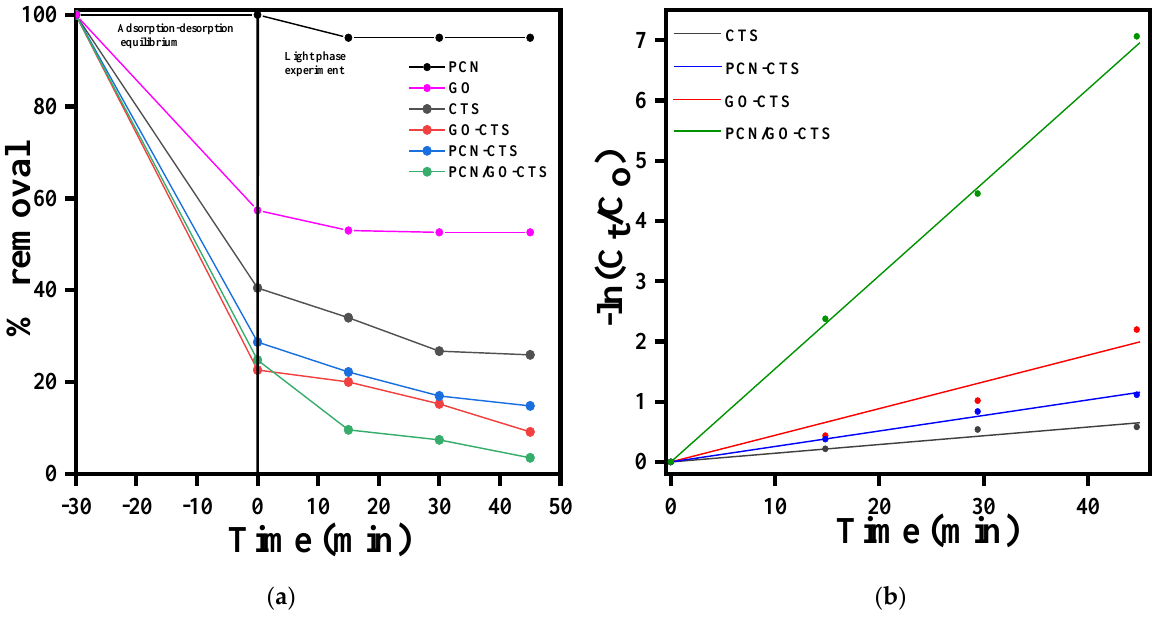
Figure 6. ( a ) Degradation profile of 5 mg/L of TCE using PCN, GO, CTS, GO − CTS, PCN − CTS, and PCN/GO − CTS, and ( b ) kinetics of degradation TCE by CTS, GO − CTS, PCN − CTS, and PCN/GO − CTS. Table 1. Comparative parameters for the degradation of TCE by CTS, PCN − CTS, GO − CTS, and PCN/GO − CTS under UV light irradiation.